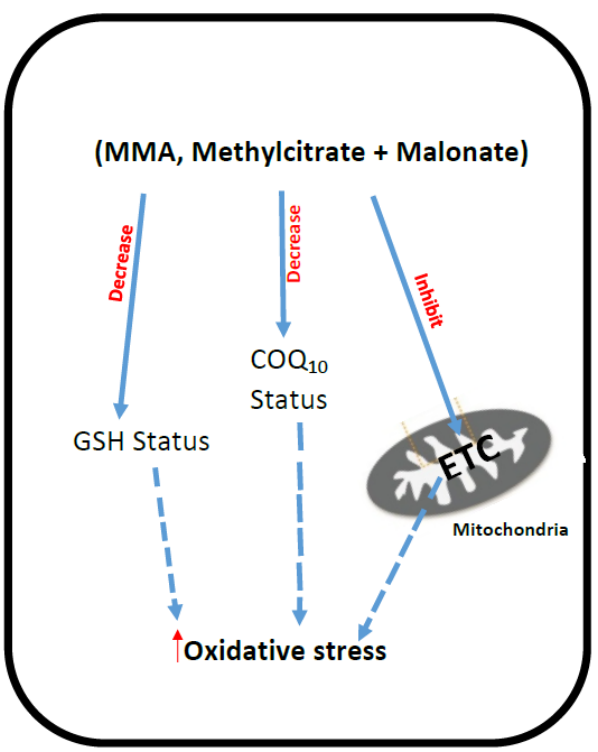
Figure 4. Putative mechanisms of oxidative stress generation and mitochondrial dysfunction in Methylmalonic acidemia. MMA: Methylmalonic acid; ETC: Mitochondrial electron transport chain; CoQ 10 : Coenzyme Q 10 ; GSH: Reduced glutathione; ROS: Reactive oxygen species. CoQ 10 : Coenzyme Q 10 ; GSH: Reduced glutathione; ROS: Reactive oxygen